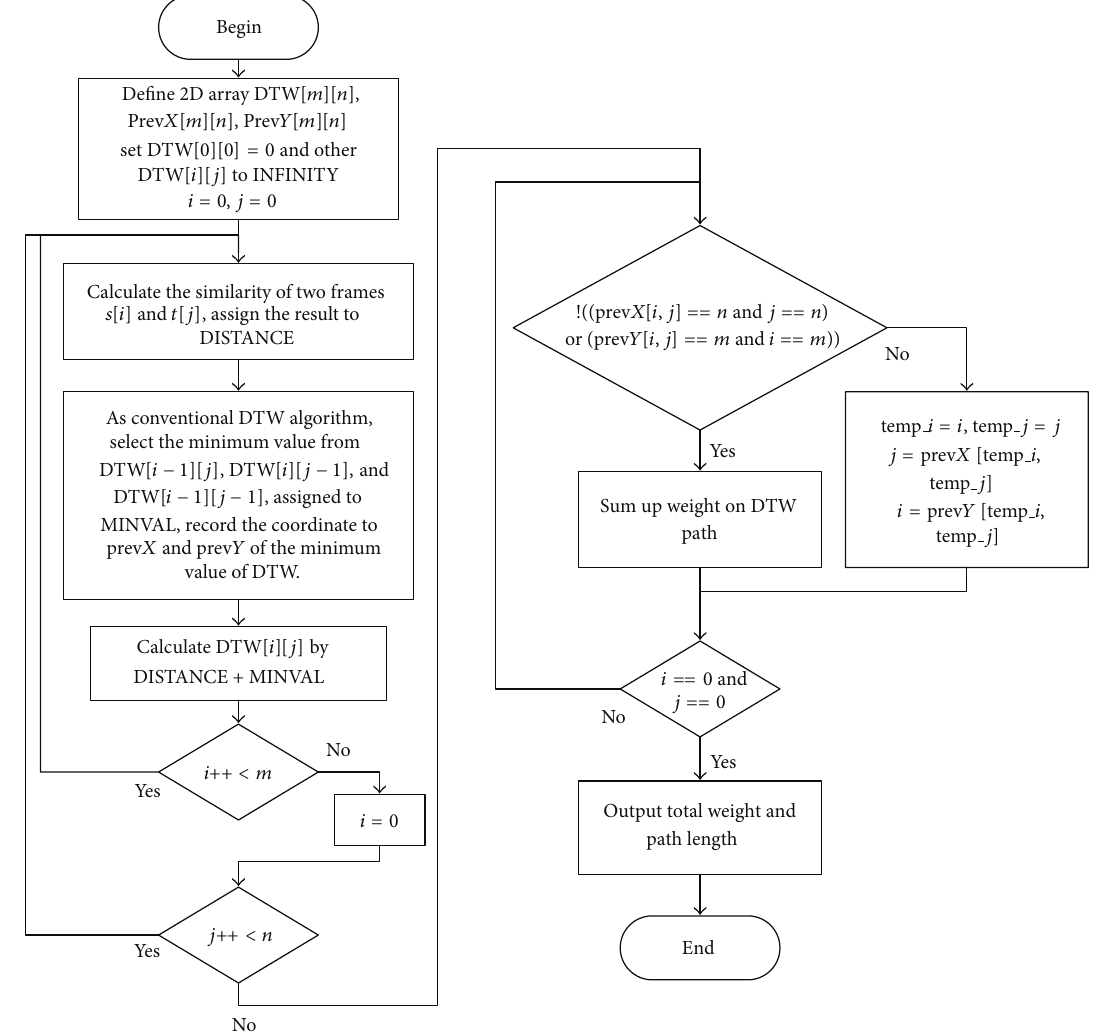
Figure 6: Flowchart of auto-aligned